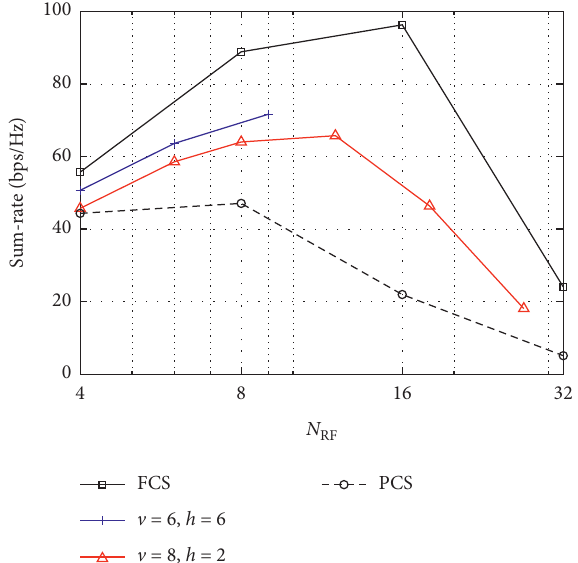
Figure 5: Sum-rate versus the number of RF chains for different antenna